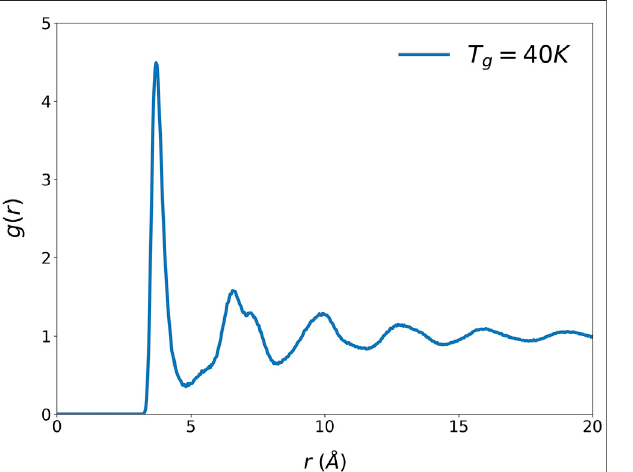
FIGURE 3 | The G 0 ( r ) of liquid Argon at T g = 40 K obtained by Eq. 1 .